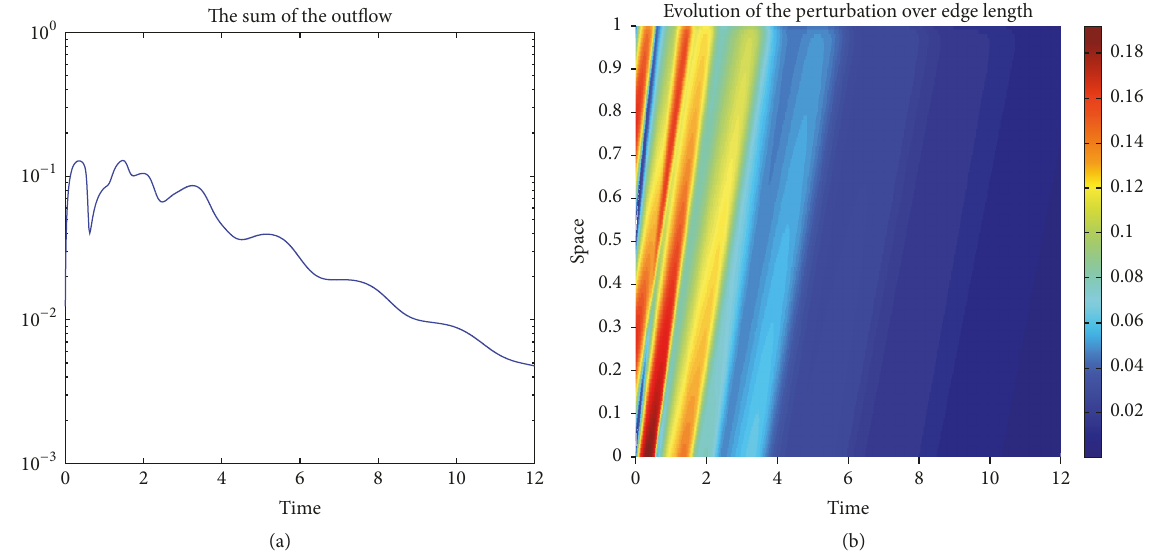
Figure 4: (a) The decay of the initial perturbations over time at the end of edge 3 and edge 4 in log-scale. (b) The evolution of the perturbation in time and